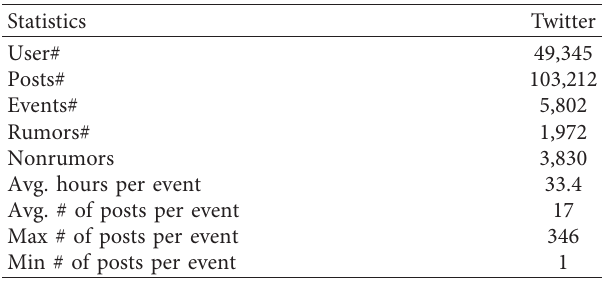
Figure 3: BiGRU (left) and GRU update process (right). Table 1: Twitter standard dataset information. Table 2: Confusion